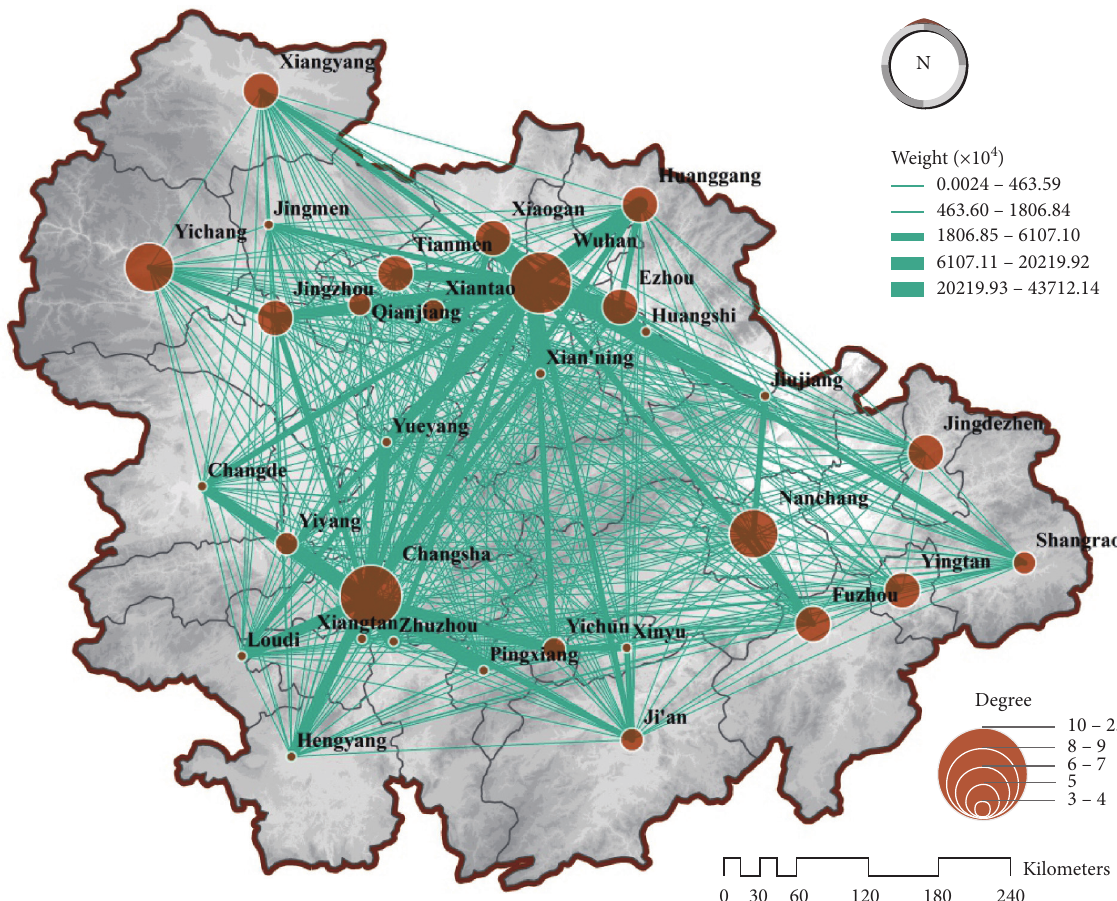
Figure 3: CO 2 emission network of the Yangtze River middle reaches megalopolis in